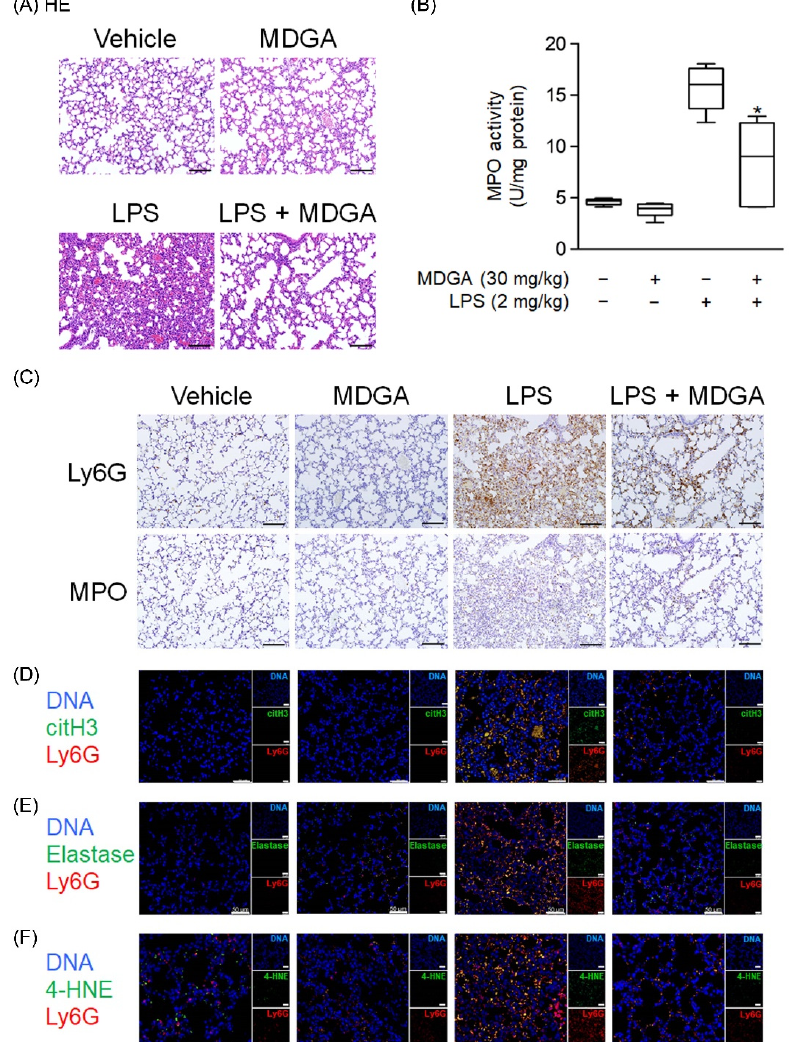
Figure 8. meso -Dihydroguaiaretic acid (MDGA) attenuates lipopolysaccharide (LPS)-induced neu- trophilic lung inflammation. BALB/c mice were intraperitoneally treated with DMSO or MDGA (30 mg/kg) for 1 h, and LPS was administered intratracheally for 6 h. Mice were divided into four groups: vehicle, MDGA only, LPS only, and LPS with MDGA groups. ( A ) HE stains of the lung. ( B ) An assay to evaluate lung MPO activity. ( C ) Images of Ly6G and MPO in lung sections. Immunofluo- rescence staining of 4’,6-diamidino-2-phenylindole (DAPI), lymphocyte antigen 6 complex locus G6D (Ly6G), histone H3 (citH3) ( D ), elastase ( E ), and 4-HNE ( F ) in lung sections. Data are illustrated as the mean ± S.E.M. ( n = 6). * p < 0.05 vs. the LPS